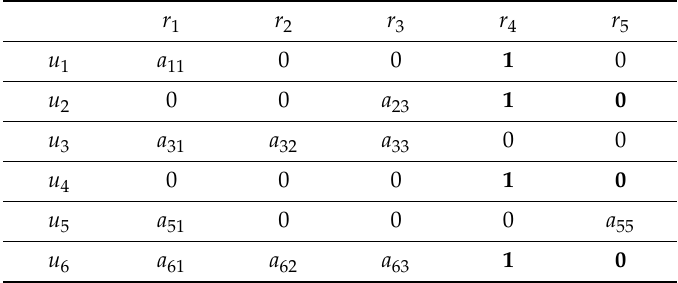
Table 12. Assignments in step